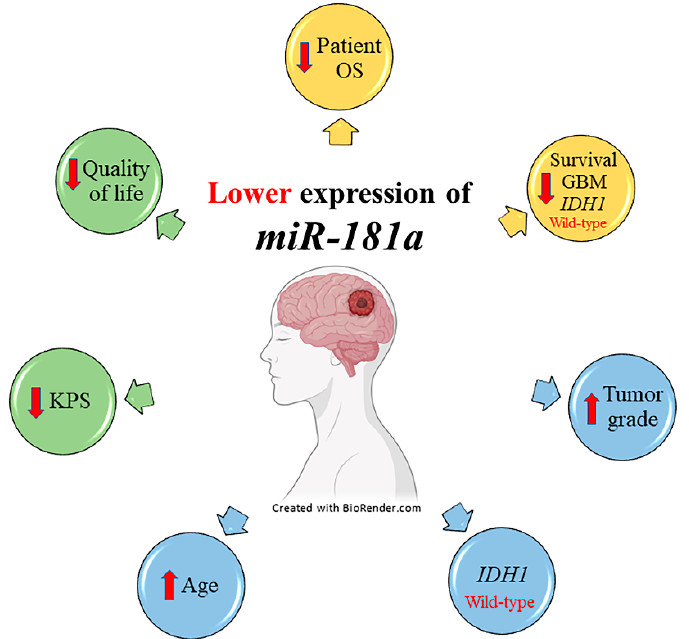
Figure 4. Statistically significant associations between expression of miR-181a and patient clinical data and psychology. KPS—Karnowski performance scale. The up arrow indicates higher tumor grade and older patient age, while down arrow—shorter patient survival time, lower KPS index, and worse patient quality of life.